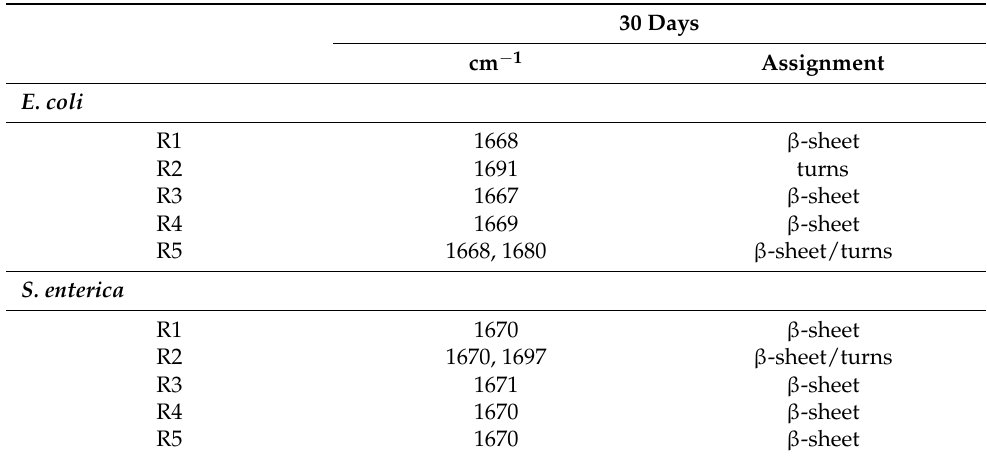
Table 2. Main band positions of Amide I in FT-Raman spectra of studied peptides in aqueous solution after 30 days of incubation at 37 ◦ C. Band positions (cm − 1 ) along with tentative assignments based on the most intensive local minima of the second derivatives. 30 Days cm − 1 Assignment E. coli R1 1668 β -sheet R2 1691 turns R3 1667 β -sheet R4 1669 β -sheet R5 1668, 1680 β -sheet/turns R1 1670 β -sheet R2 1670, 1697 R4 1670 β -sheet R5 1670 β